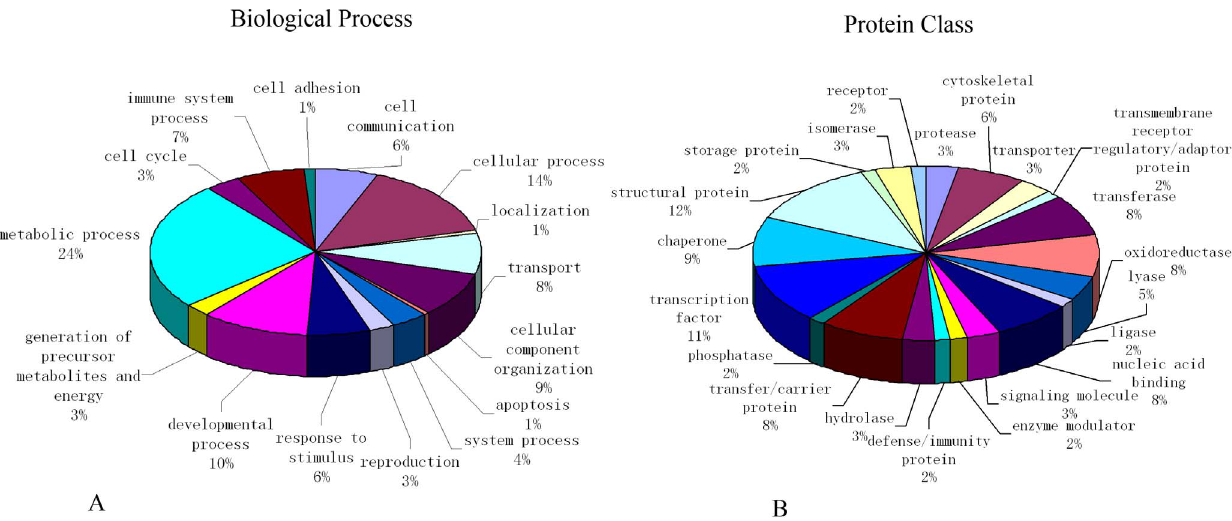
Figure 2. Classification of differentially expressed proteins according to their biological process and protein class. Pie charts display classification of the subset of differentially expressed proteins divided into 15 biological processes (A) and 21 protein classes (B). Molecular functions regulated by the differentially expressed proteins as classified by Gene Ontology.